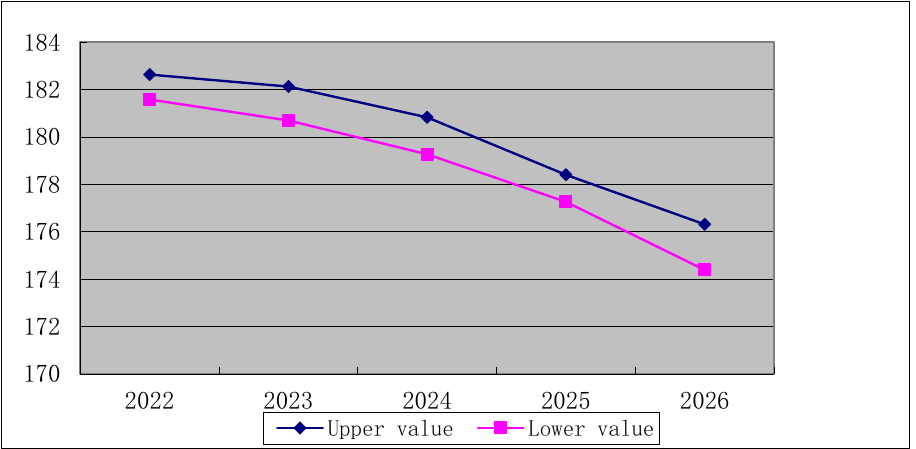
Figure 13. The variation interval of water requirement with the influence of population in Hebei Province.